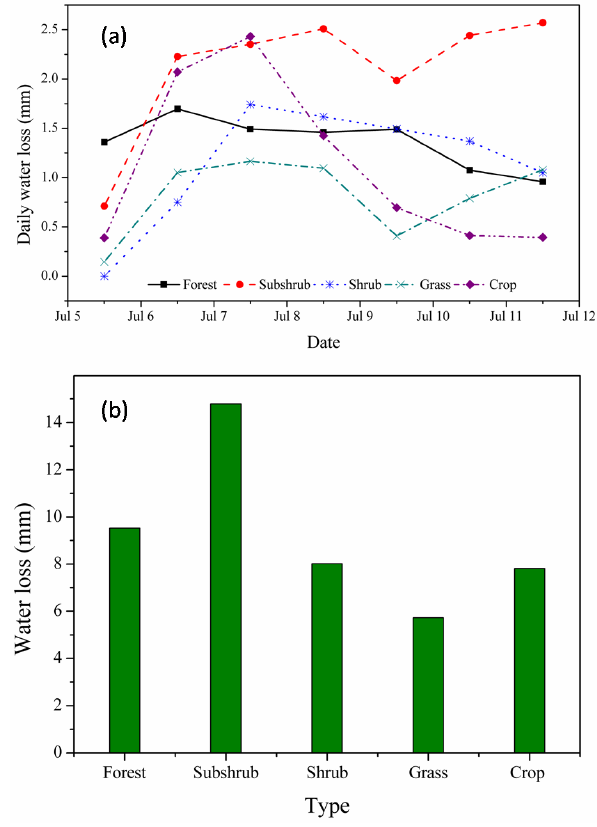
Fig. 5. Daily soil water loss (a) and cumulative water loss (b) under the five land cover types from 6 July to 12